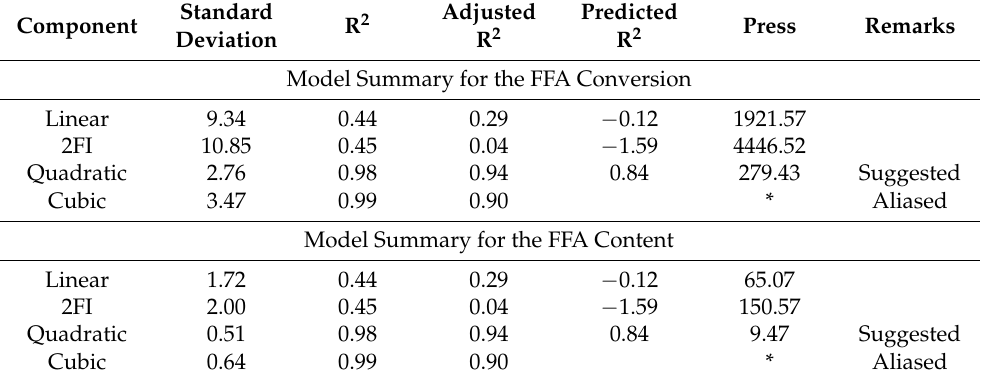
Table 5. Model Summary